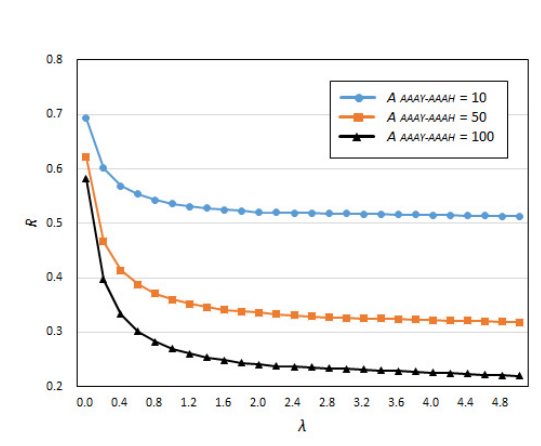
Figure 12. Change of signaling overhead ratio (Proxy-AAA / traditional AAA).